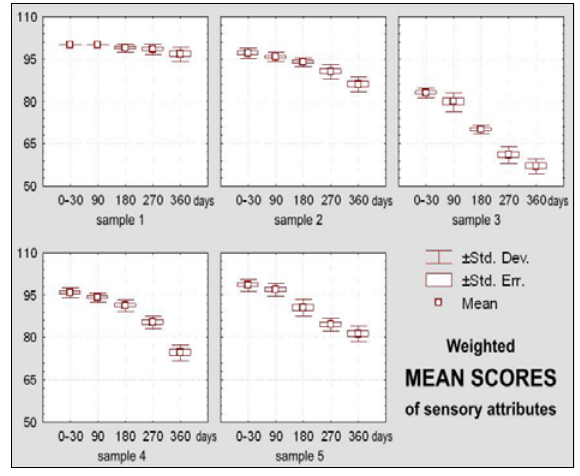
Figure 10 . Box-plots for weighted mean score for evaluated sensory attributes of dietary chocolate.